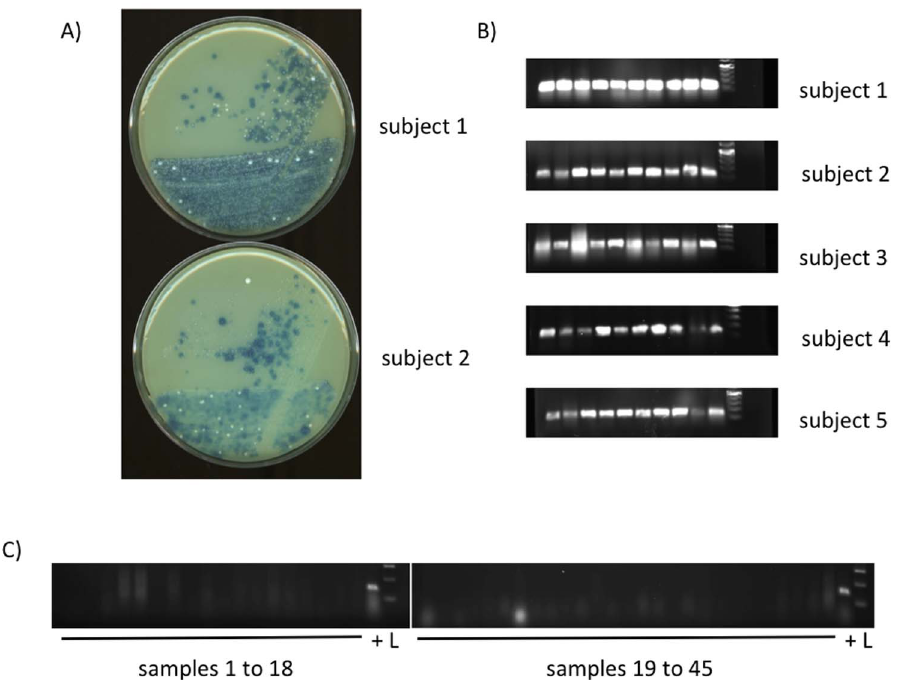
Figure 3. H 2 O 2 production and spxB presence in plaque samples. A) Plaque samples for spreading on the H 2 O 2 indicator plate were collected by swapping over several tooth with a sterile cotton swap. After inoculation, the indicator plates were incubated over night aerobically. Shown are representative plates from two subjects. B) Respective blue colonies indicating H 2 O 2 production were picked and used for genomic spxB amplification. 16S rRNA was used as positive control, with bands for all tested colonies (not shown). C) 45 white colonies were also tested for spxB amplification. L=ladder, + =chromosomal DNA S. gordonii DL1.